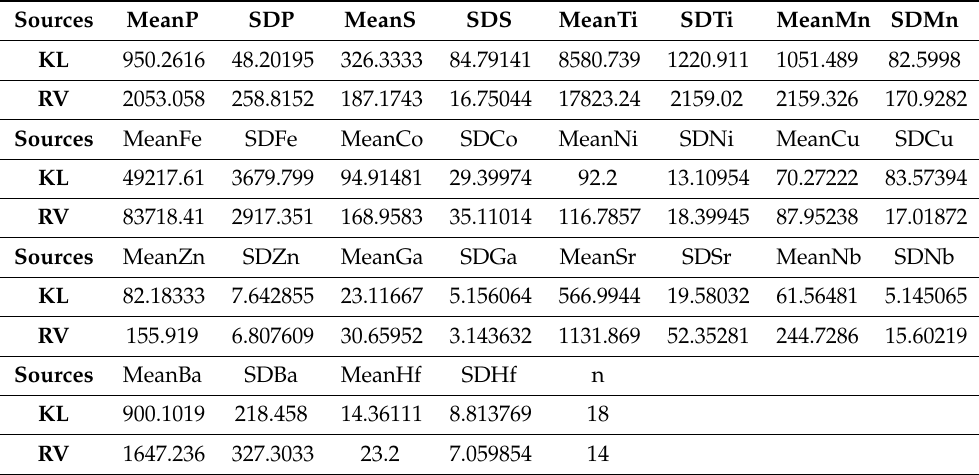
Table A6. Tributary source tracer values in means and standard deviations (SD) and the